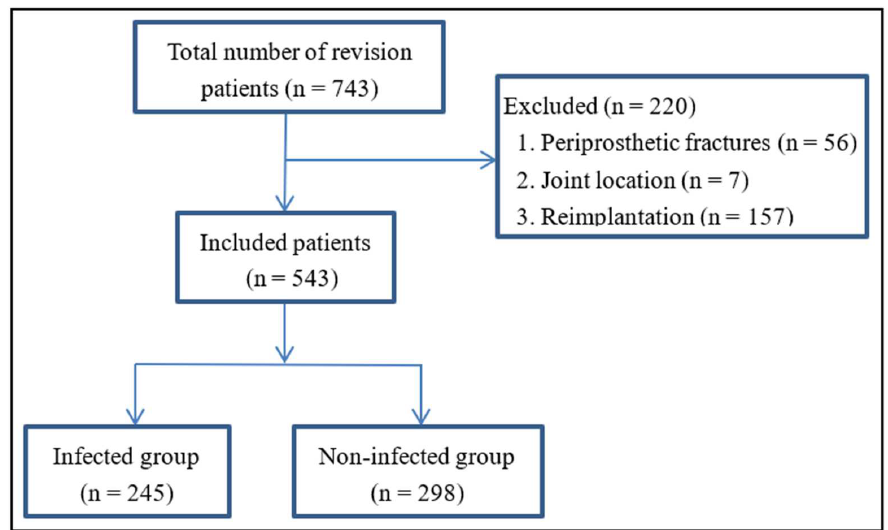
Figure 1. Flow diagram of the study design. Table 1. Characteristics of patients with or without periprosthetic joint infection.